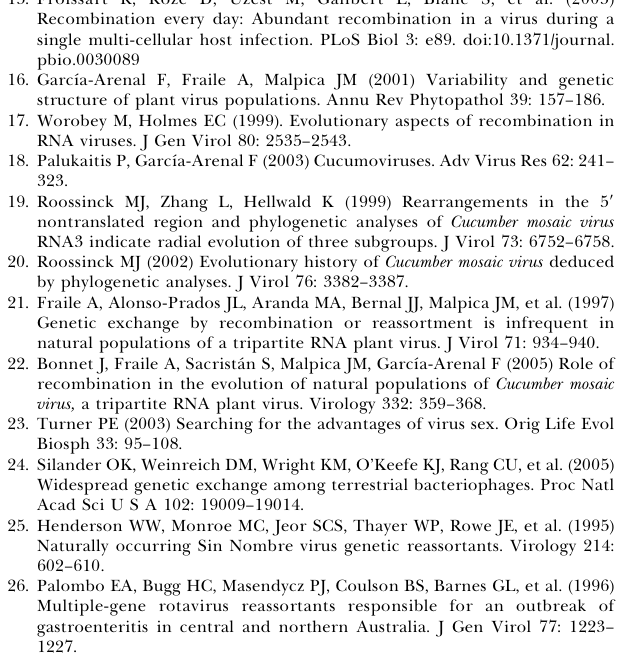
Table S4. Frequency Distribution of Genetic Types in Progenies from Double Inoculations of IA and IB CMV Isolates on the Systemic Host Nicotiana tabacum cv. Xanthi-nc Progenies recovered from total RNA extracts of TSL. Data are number of descendants and frequencies referred to the total of the progeny (between brackets). Genotype distributions with the same letter did not differ at a 95% level of confidence. Found at doi:10.1371/journal.ppat.0030008.st004 (65 KB